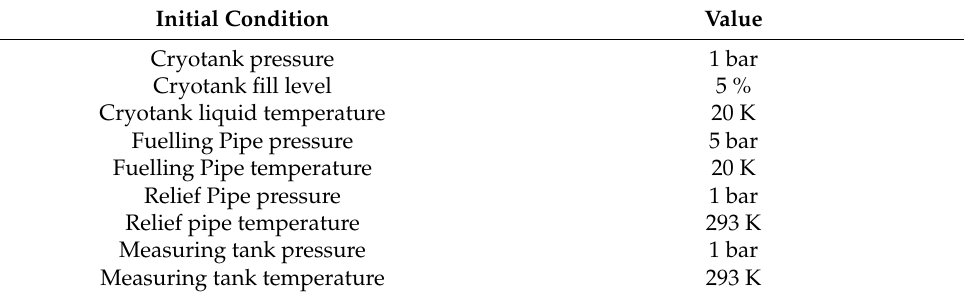
Table 2. Selected initial conditions of the Fuelling